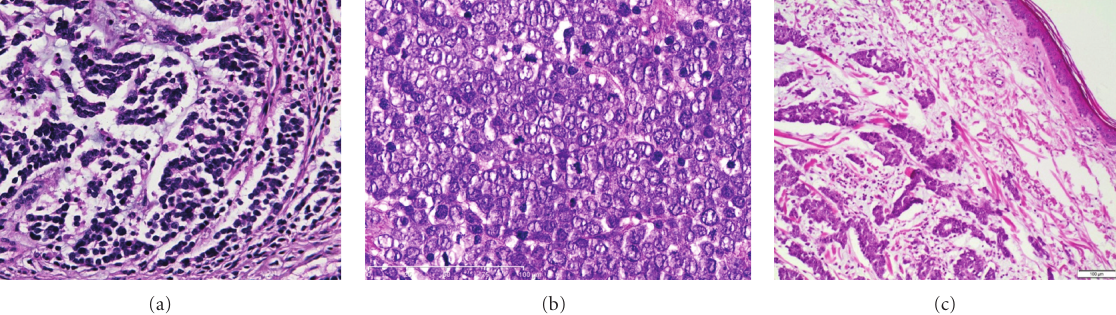
Figure 1: (a) Small-cell variant, histologically indistinguishable from bronchial small-cell carcinoma. (b) Intermediate variant of MCC showing vesicular, basophilic nuclei with prominent nucleoli and high mitotic activity. (c) Trabecular variant is rare and normally only seen as a small component of a mixed